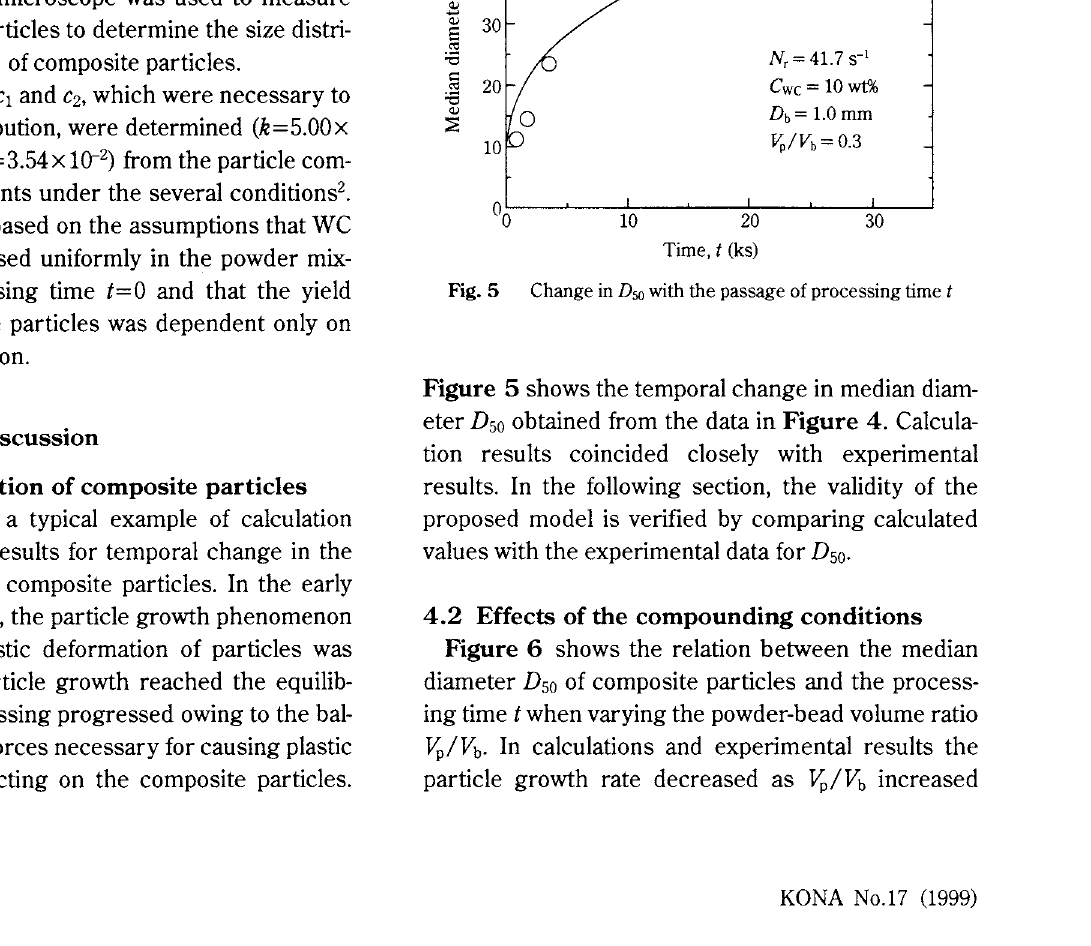
Fig.4 Change in size distribution curves with the passage of processing timet (Cwc= 10 wt%, Db= 1.0 mm, N,=41.7 s- 1, V.,/Vb=0.3)